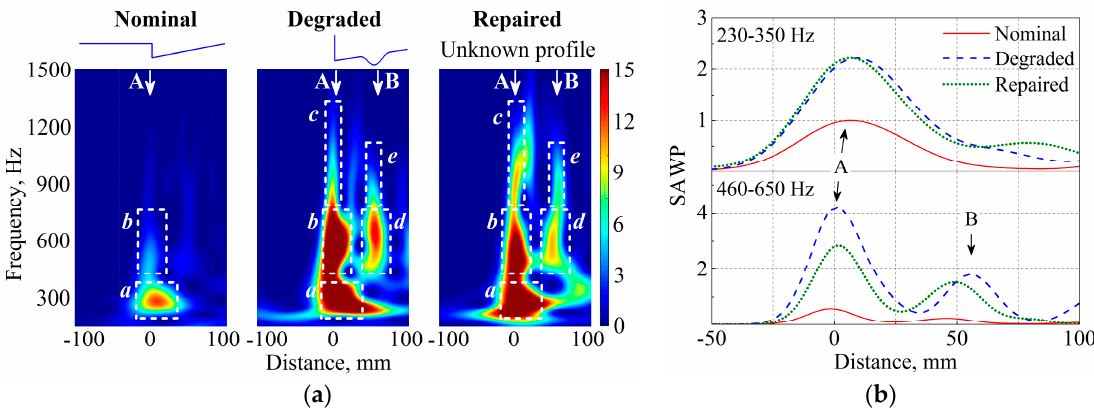
Figure 12. Comparison of ABA of nominal, degraded and repaired states. ( a ) WPS and ( b ) SAWP. The rectangles indicate the major characteristics. Arrows A and B indicate the location of degradation types 1 and 2.